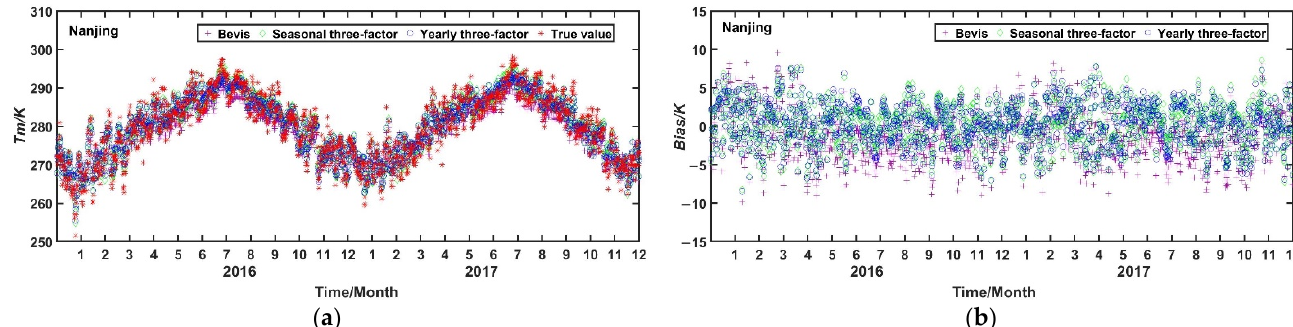
Figure 6. The statistical histograms of the biases of Bevis model, yearly and seasonal three-factor RTMs in spring ( a ), summer ( b ), autumn ( c ) and winter ( d ).